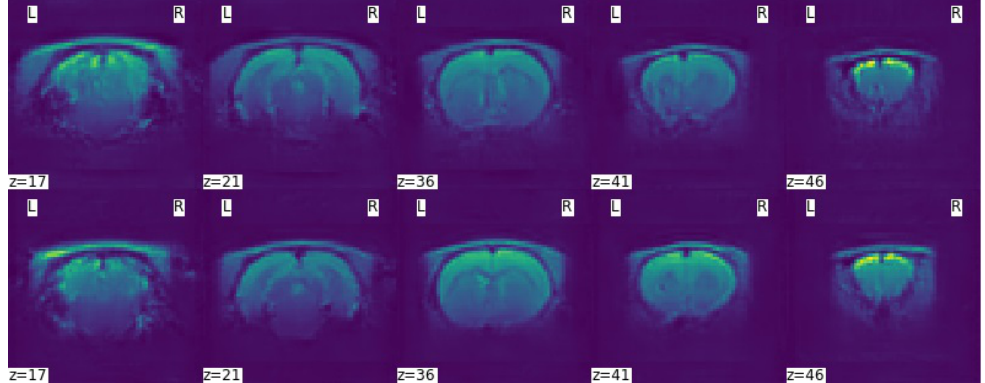
Figure 9. Axial slices of a generated scan with the α -WGANSigmaRat2 model after 100,000 iterations (first row) and after 200,000 iterations (second row) of training. L and R refer to the left and right sides of the brain